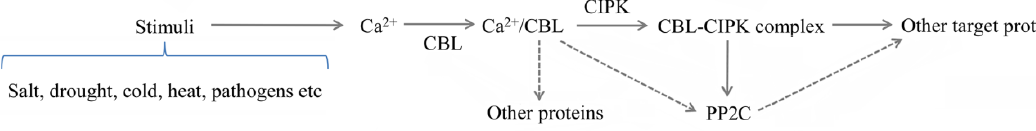
Figure 5. A model of CBL-CIPK pathway during stimuli. CBLs combine with the Ca 2+ increased by stimuli, and activate the CIPKs in response to relevant stresses. The solid lines represent the classical Ca 2+ /CBL-CIPK signaling. The atypical function of CBLs and the target protein PP2C are shown with dotted lines.